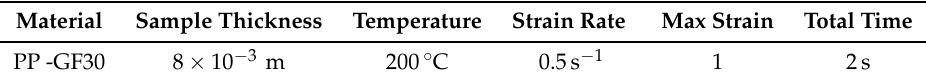
Table 1. Process settings of the non-lubricated squeeze flow experiment for a 30% wt. glass fiber reinforced polypropylene (PP) in [17].